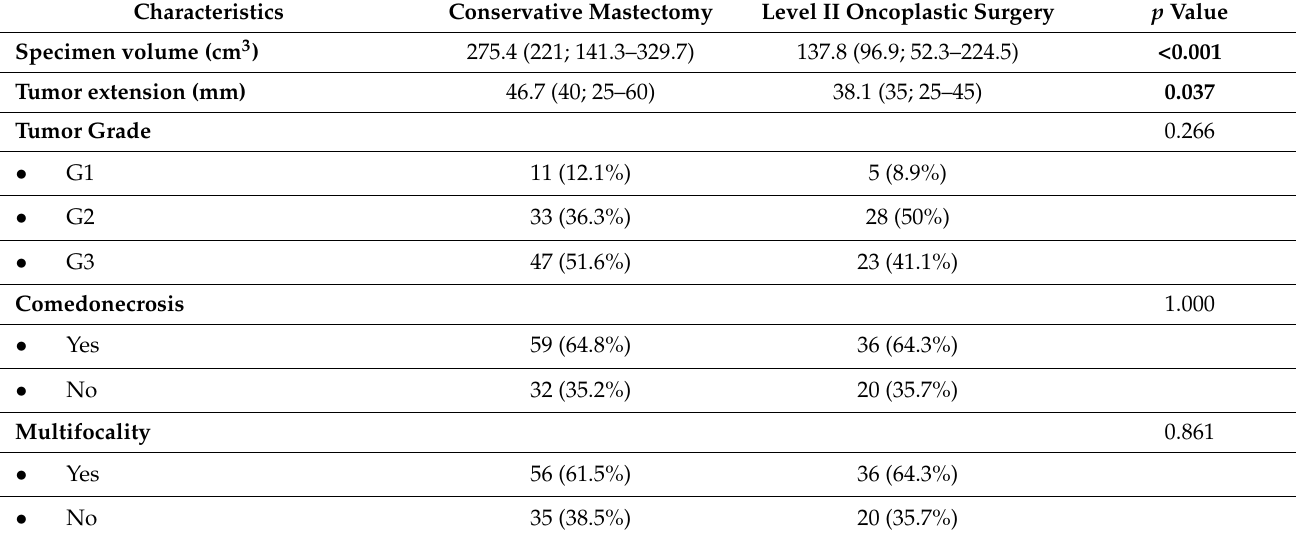
Table 3. Final Histology Tumor